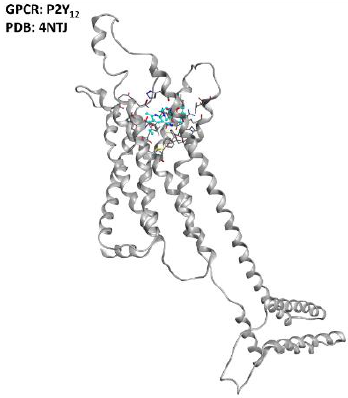
Figure 5. Representation of the structure of the P2Y 12 receptor (sourced from the Protein Data Bank, PDB code: 4NTJ [101], method: X-ray diffraction, resolution: 2.62 Å). The image was created and rendered with MOE.